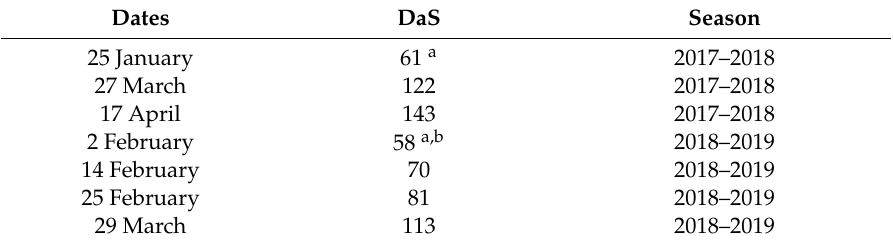
Table 1. Dates of measurements and imagery acquisition during the trial seasons.